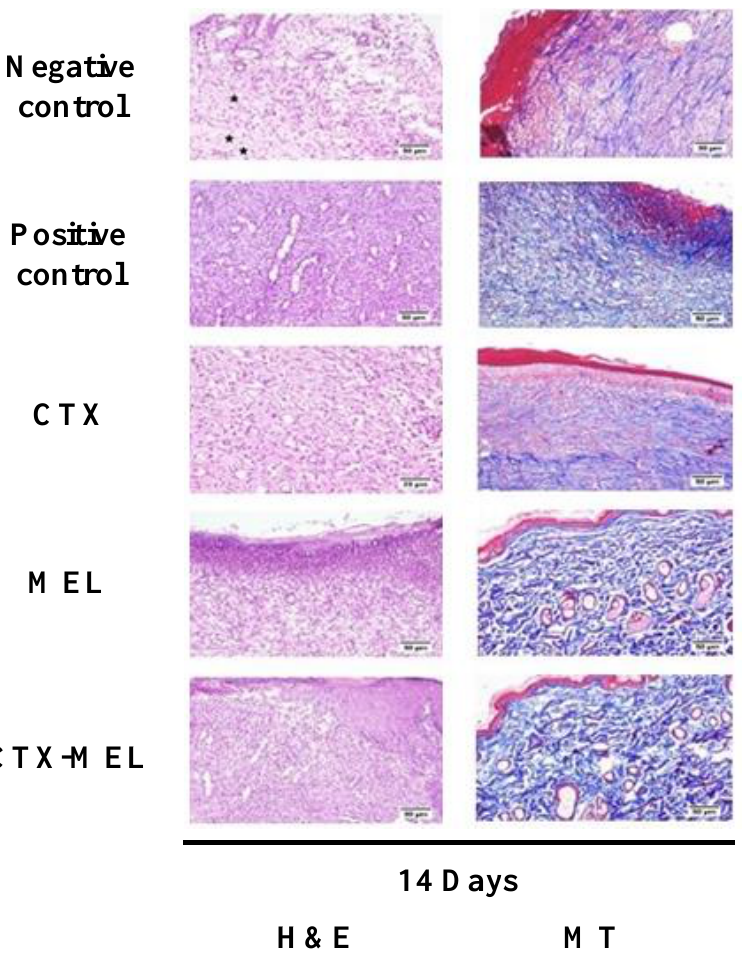
Figure 3. Histopathological effects of CTX, MEL, or CTX–MEL nanocomplex on wound healing on day 14. Negative control refers to rats that received topical plain vehicle consisting of HPMC-based hydrogel (1.5% w / v ) on the wound area, while positive control refers to animals that received 0.5 g of Mebo TM ointment on the wound area. H&E = hematoxylin and eosin (scale bar = 50 µm); MT = Masson’s trichrome (scale bar = 50 μm).